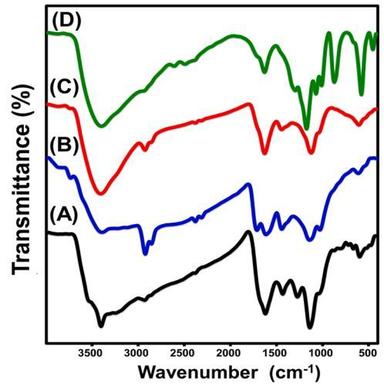
Shows the FT-IR spectra of raw coal (A), modified SC-75 sample (B), modified SC-85 sample (C), and modified SC-95 sample (D).